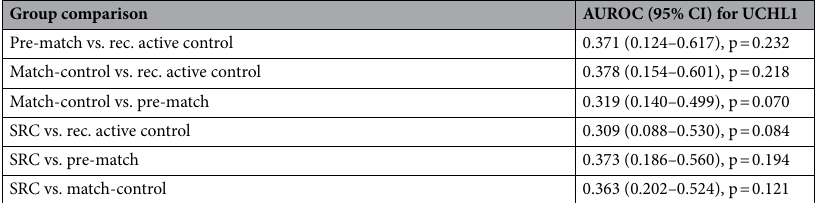
Group comparison AUROC (95% CI) for UCHL1 Pre-match vs. rec. active control 0.371 (0.124–0.617), p = 0.232